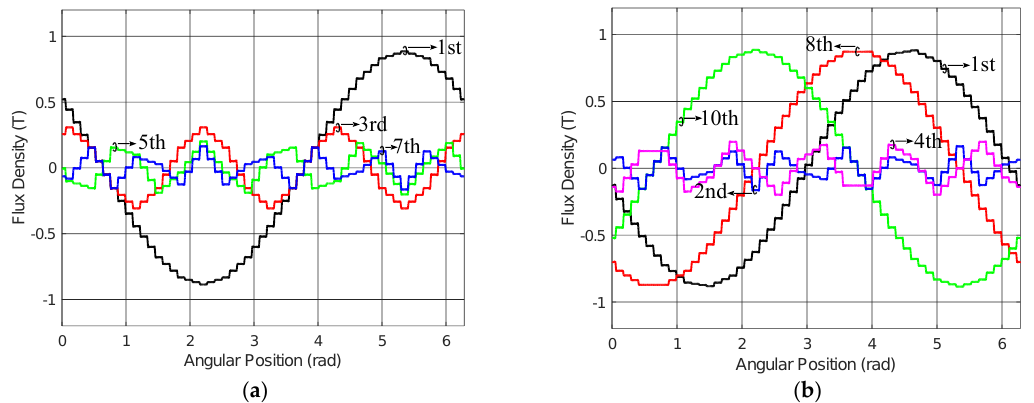
Figure 10. Time harmonics acting in multiphase winding: ( a ) harmonics suitable for injection, ( b ) harmonics inappropriate for injecting.